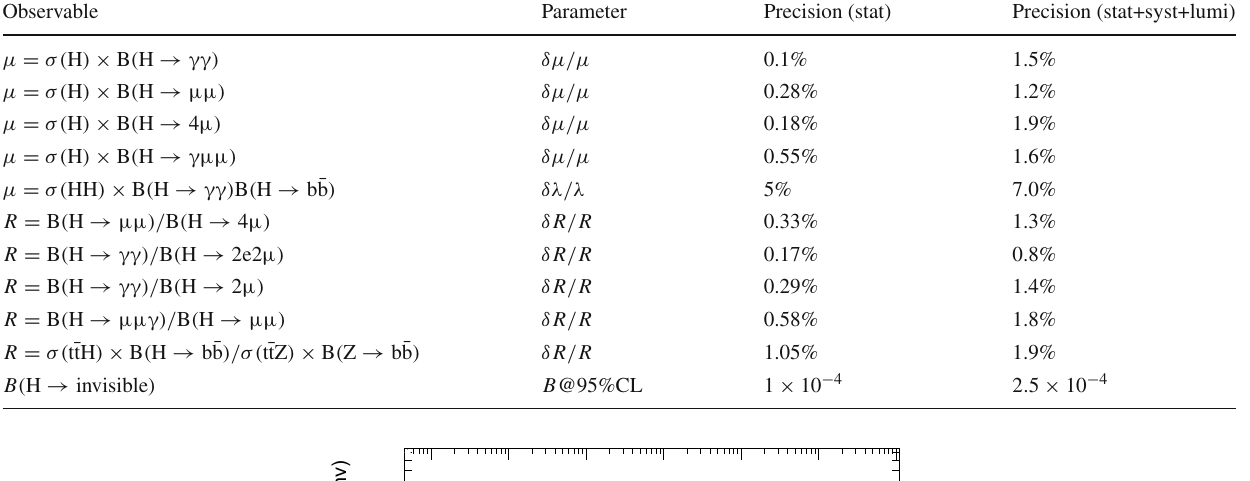
Table 4.4 Target precision for the parameters relative to the measure- ment of various Higgs decays, ratios thereof, and of the Higgs self- coupling λ . Notice that Lagrangian couplings have a precision that is